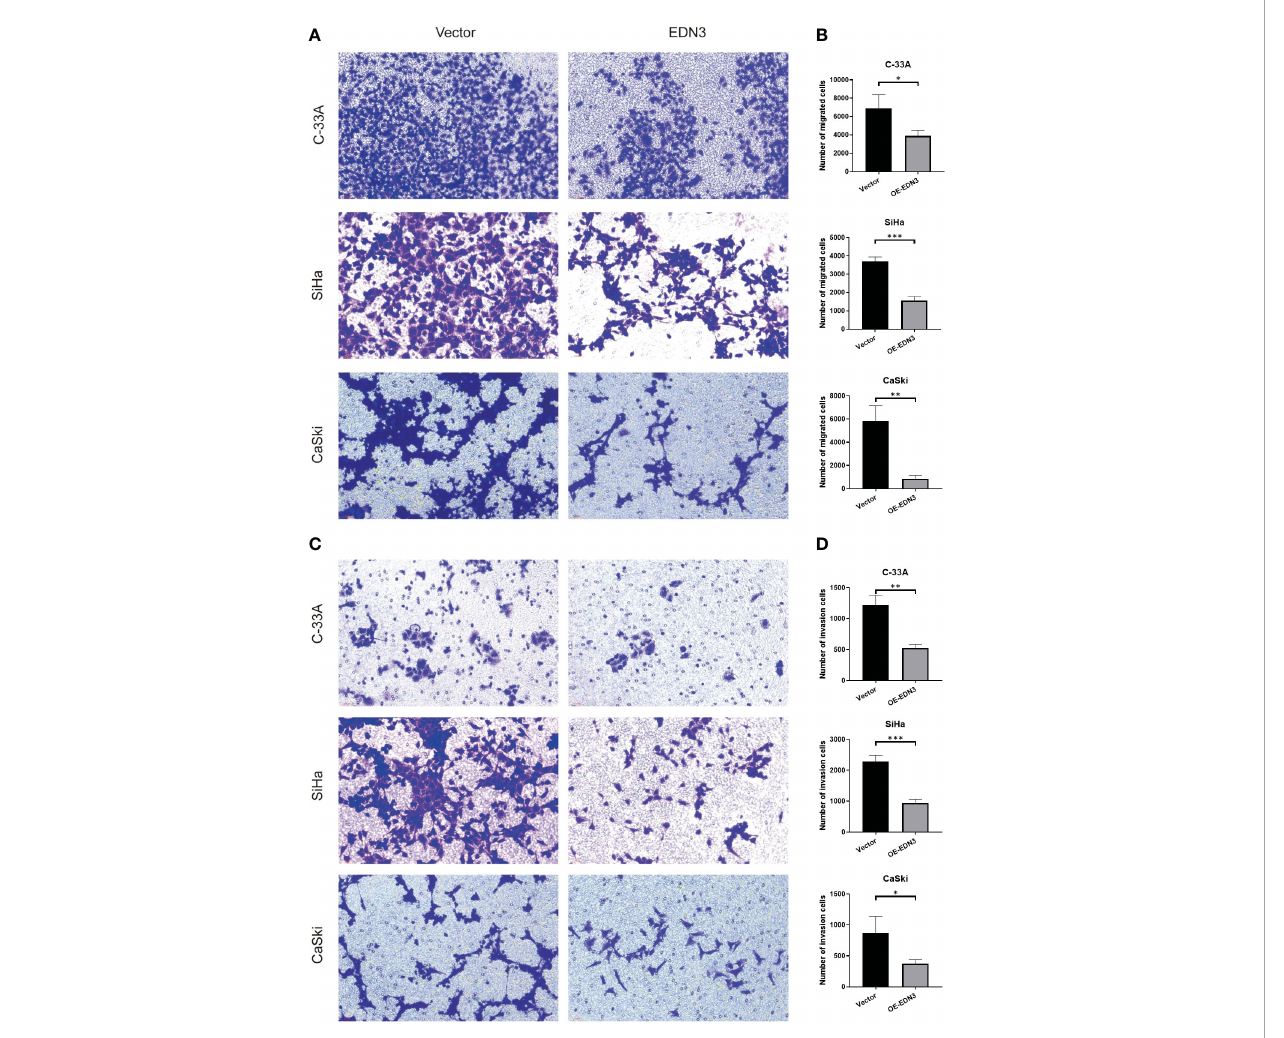
FIGURE 6 Overexpression of EDN3 inhibited the migration and invasion of C-33A, SiHa and CaSki cells by transwell assay. (A) Representative images of cell migration by transwell assay using C-33A, SiHa and CaSki cells transfected with OE-EDN3 or vector. (B) Quanti fi cation of cell migration by transwell assay is shown. Values are mean ± SD, N = 3; *P<0.05; **P<0.01; ***P<0.001. (C) Representative images of cell invasion by transwell assay using C-33A, SiHa and CaSki cells transfected with OE-EDN3 or vector. (D) Quanti fi cation of cell invasion by transwell assay is shown. Values are mean ± SD, N = 3; *, P<0.05; **, P<0.01; ***,